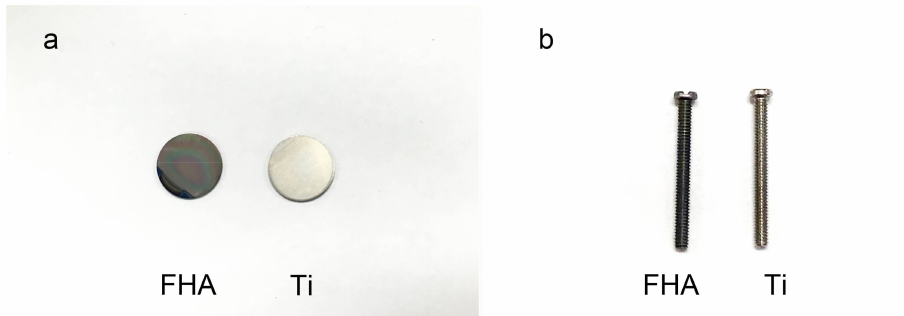
Figure 1. Gross appearance of Titanium (Ti) and fluoridated hydroxyapatite (FHA)-coated Ti ( a ) discs and ( b )